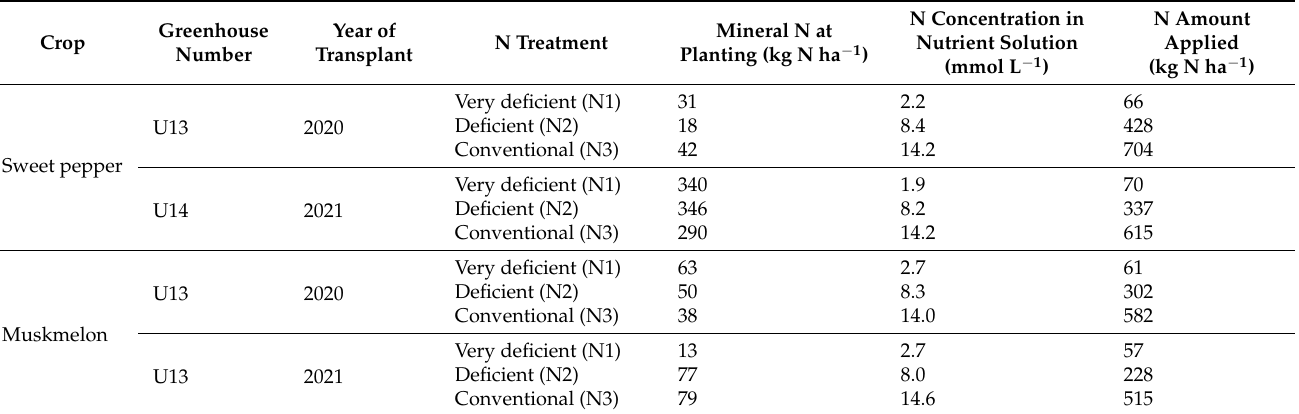
Table 1. Mineral N (NO 3 − –N + NH 4+ –N) in the soil (0–0.4 m depth) at the beginning of each crop and year, N concentration in the applied nutrient solution, and amount of mineral N applied in